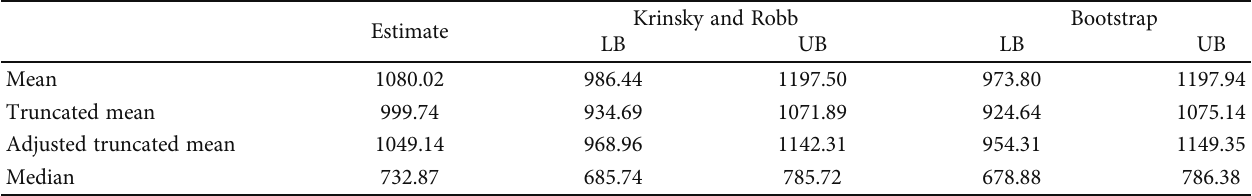
Table 11: Con fi dence intervals for the WTP of the log-normal model (source: authors). Estimate